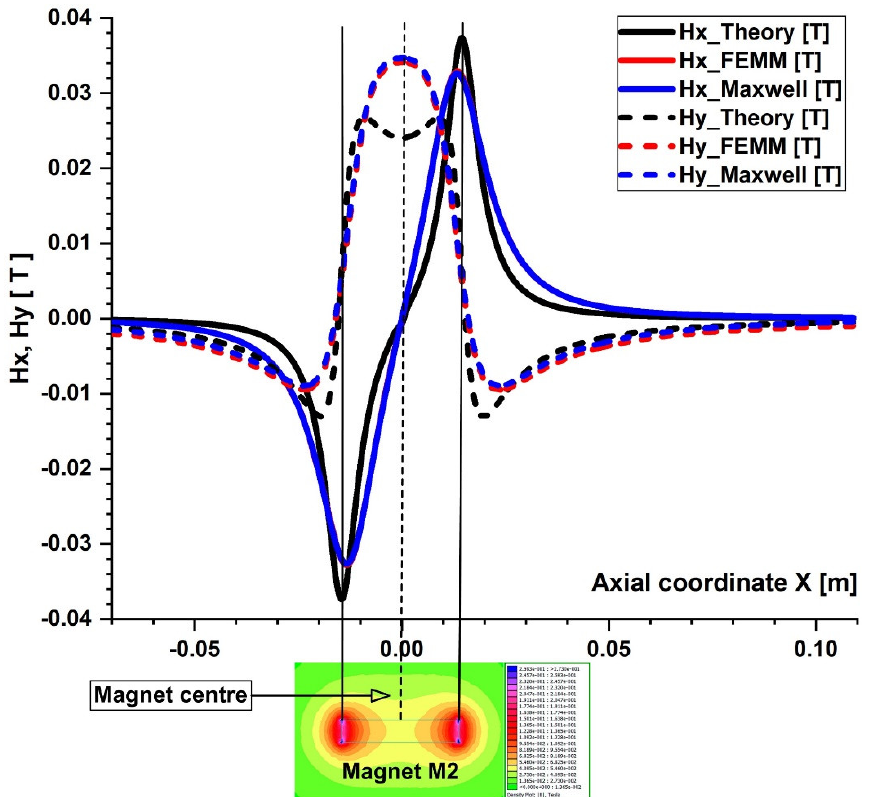
Figure 10. Comparison of the magnetic field components H x and H y obtained analytically, experi- mentally, and using FEA (FEMM and Maxwell software) along the x direction of the bottom wall of the vessel. B-field magnitude distribution for the permanent ferrite magnet (magnet M2) grade Y35 bottom. The distance between the vessel’s bottom wall and the magnet surface is h = 5 mm.